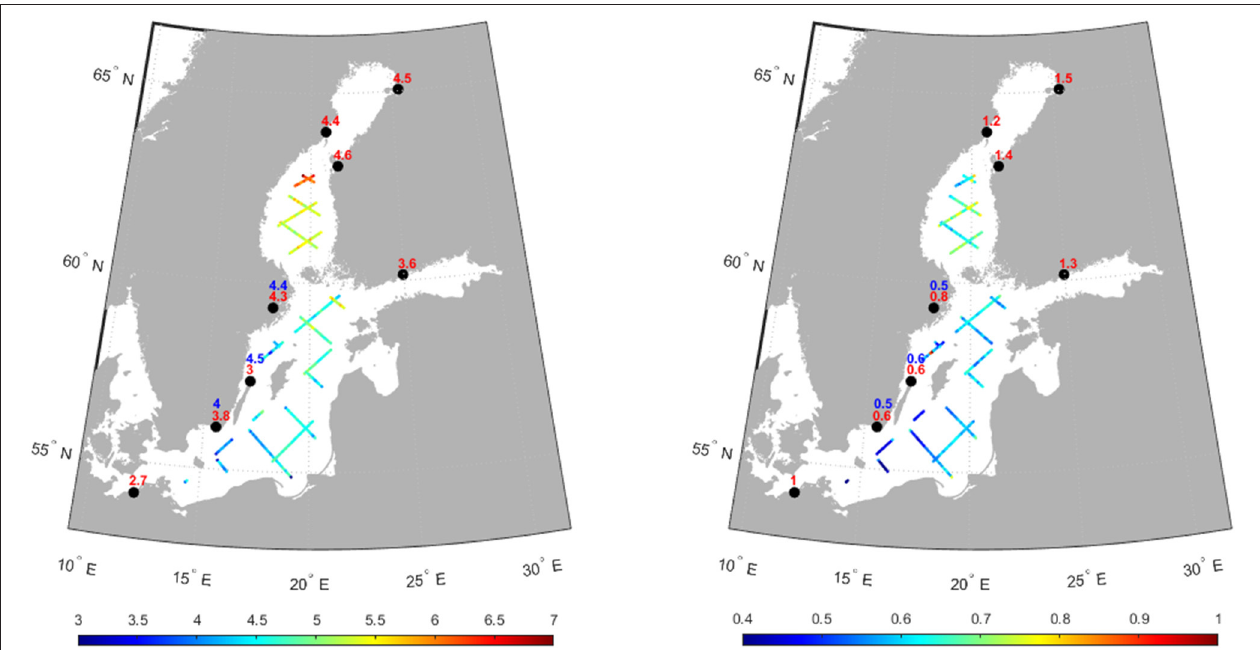
FIGURE 2 | Left panel: the sea level trend map (mm/year) estimate by Equation (2) and right panel: corresponding uncertainty map. The values in red are estimated by tide gauge data (from 1993–2020) and the blue ones are those estimated by altimetry data within a 2 ◦ × 2 ◦ box of the respective tide gauge stations. The agreement between altimetry and tide gauge is significantly high except for one of the stations located on an island.